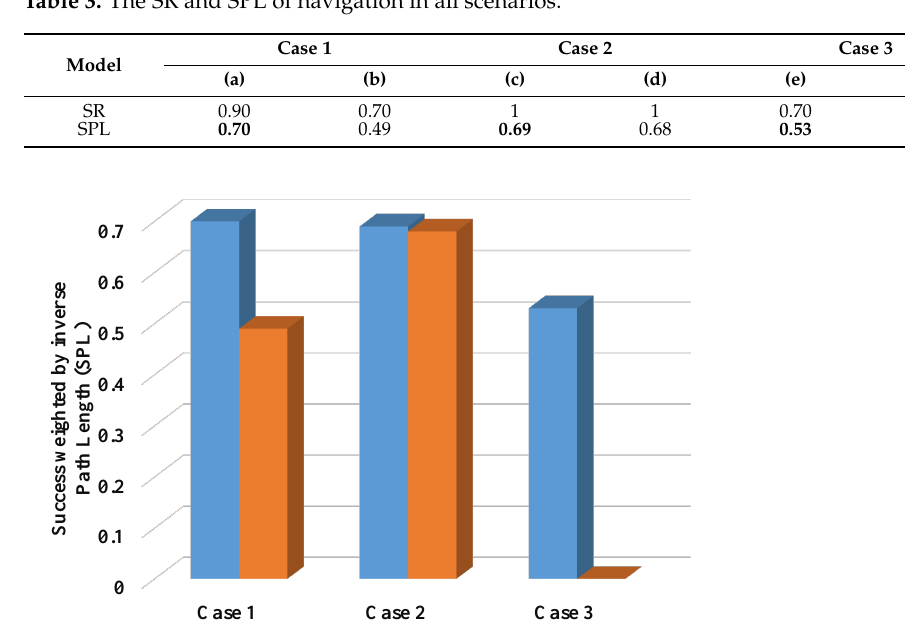
Figure 23. Bar graph of SPL results for all